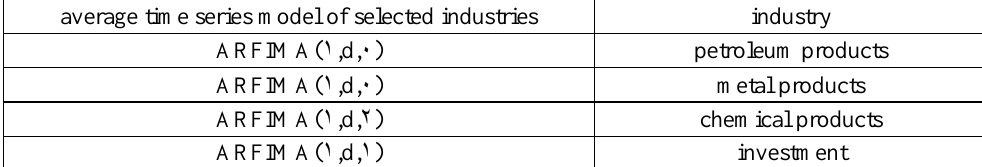
Table 5. Optimal delay determination of equations for the designated industries average time series model of selected industries industry ARFIMA(1,d,0) petroleum products ARFIMA(1,d,0)